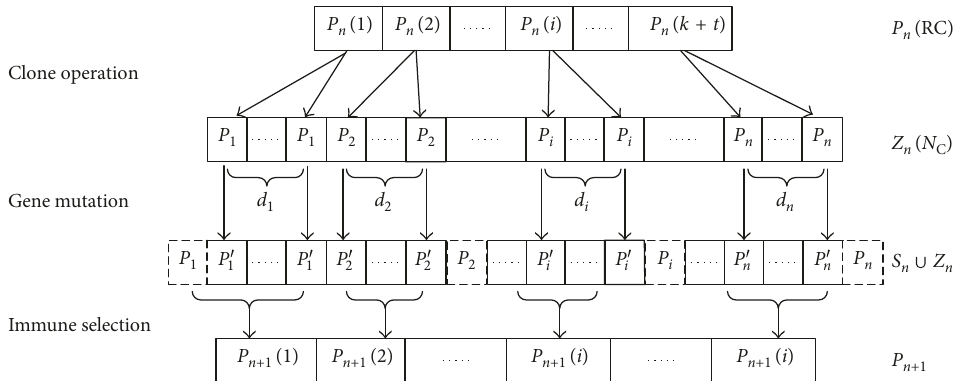
Figure 3: The process of in Table 1. The underground freight volume of each UDC the transport capacity of underground tunnels. Cargos from two metro lines can be transferred at Xinjiekou Station where the function of UD is invalid.